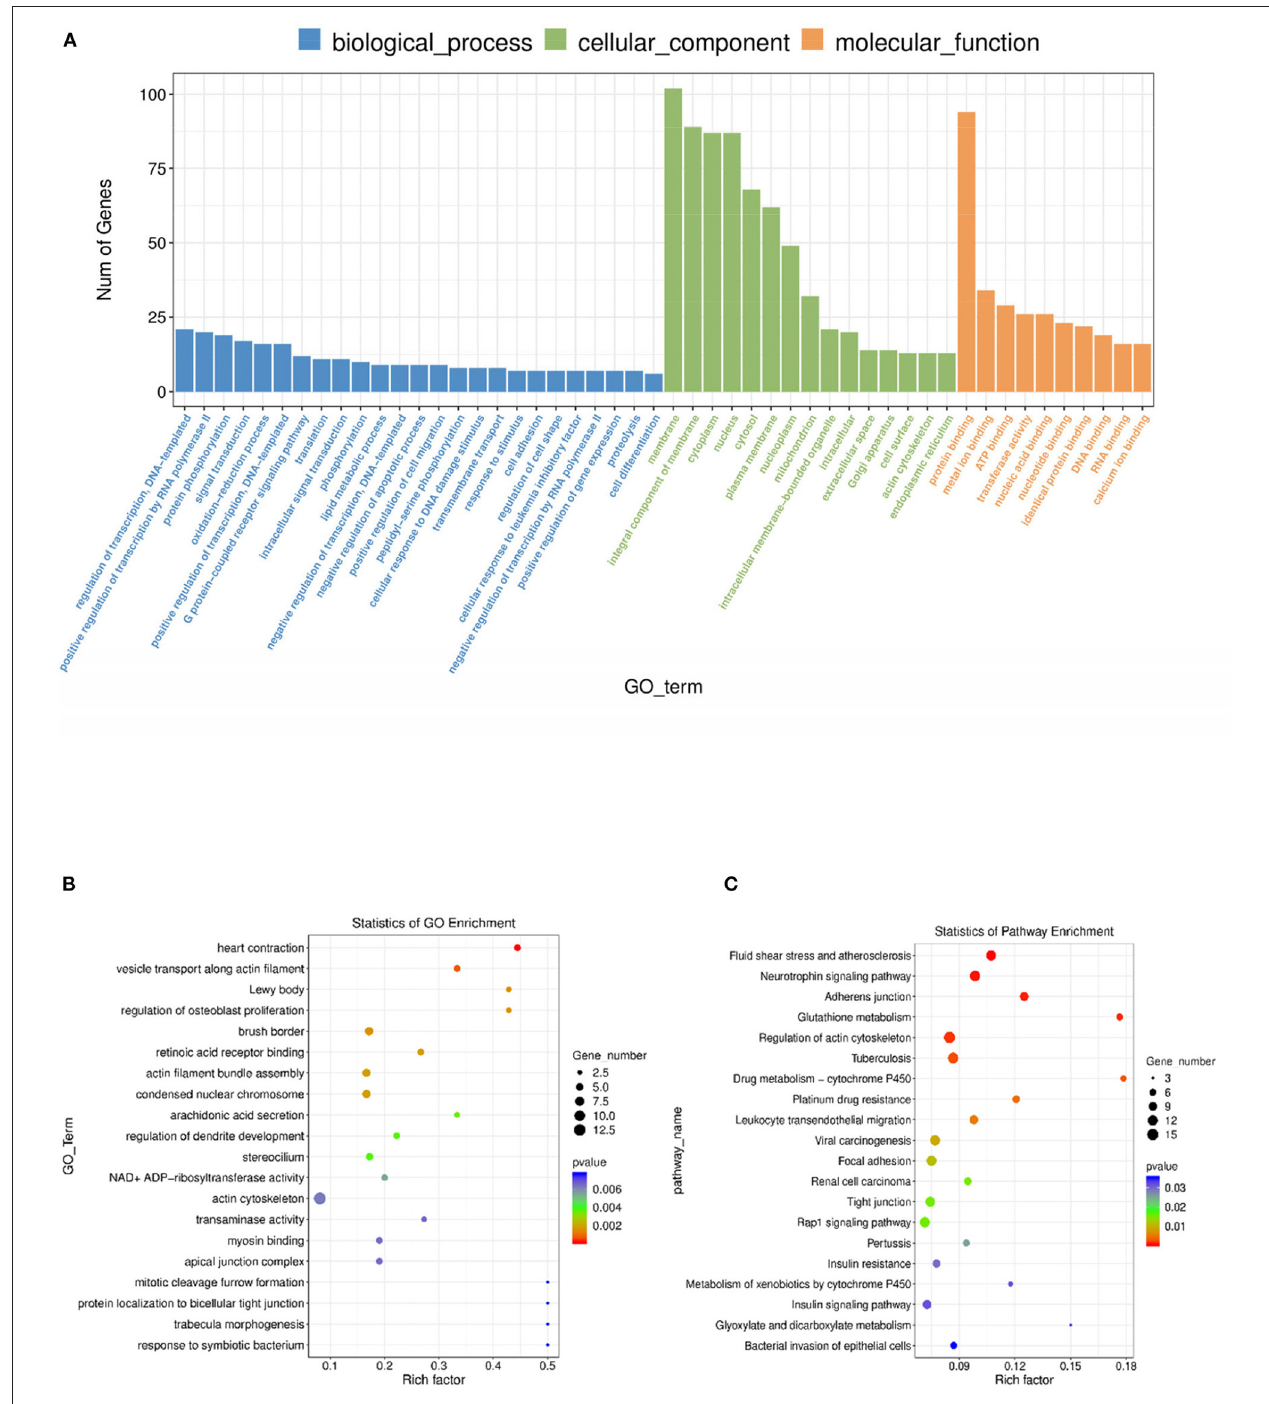
FIGURE 6 | GO and KEGG analysis of differentially lncRNA expression. (A) Histogram of GO enrichment of DE lncRNAs. (B) Scatter plot of GO enrichment for DE lncRNAs. (C) Scatter plot of KEGG enrichment for DE lncRNAs.